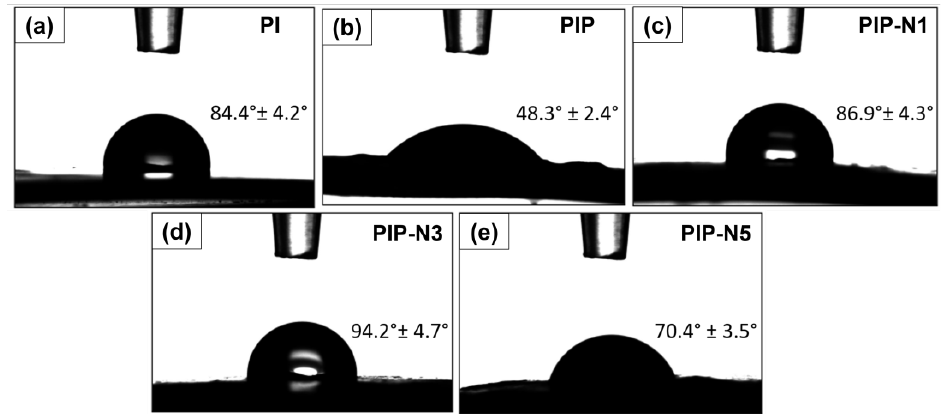
Figure 8. Contact angles of the neat polymer films and sustainable Pickering films.